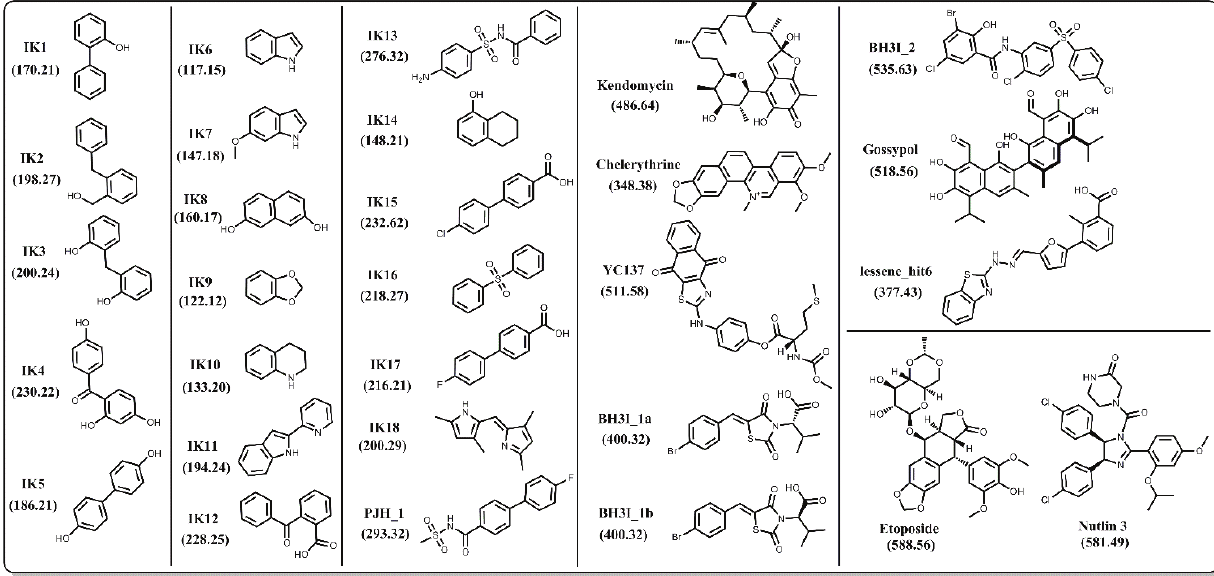
Figure 4. Chemical structures of 27 known inhibitors and two decoy compounds (Etoposide and Nutlin-3) selected for docking simulations. Numbers in parentheses are the molecular weights for each